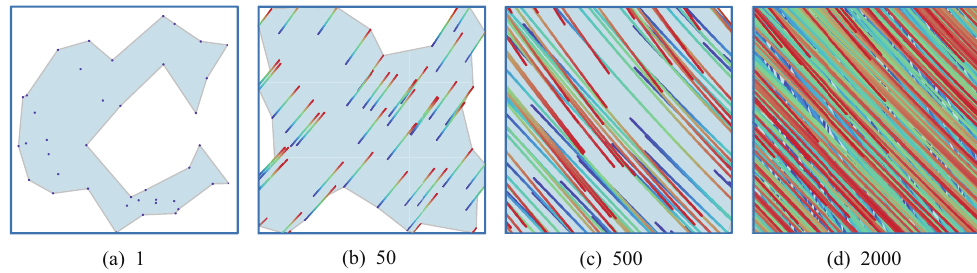
Figure 5. Stars distribution for different sampling time: ( a ) the stars distribution in 1 s, where the green background is the profile of the superposed star spots. ( b – d ) the stars in 50 s, 500 s and 2000 s,